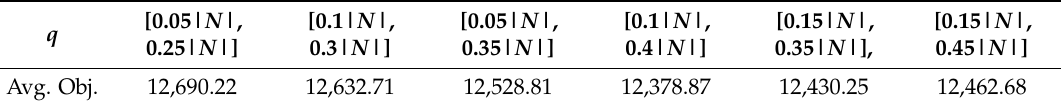
Table 3. Parameter settings for